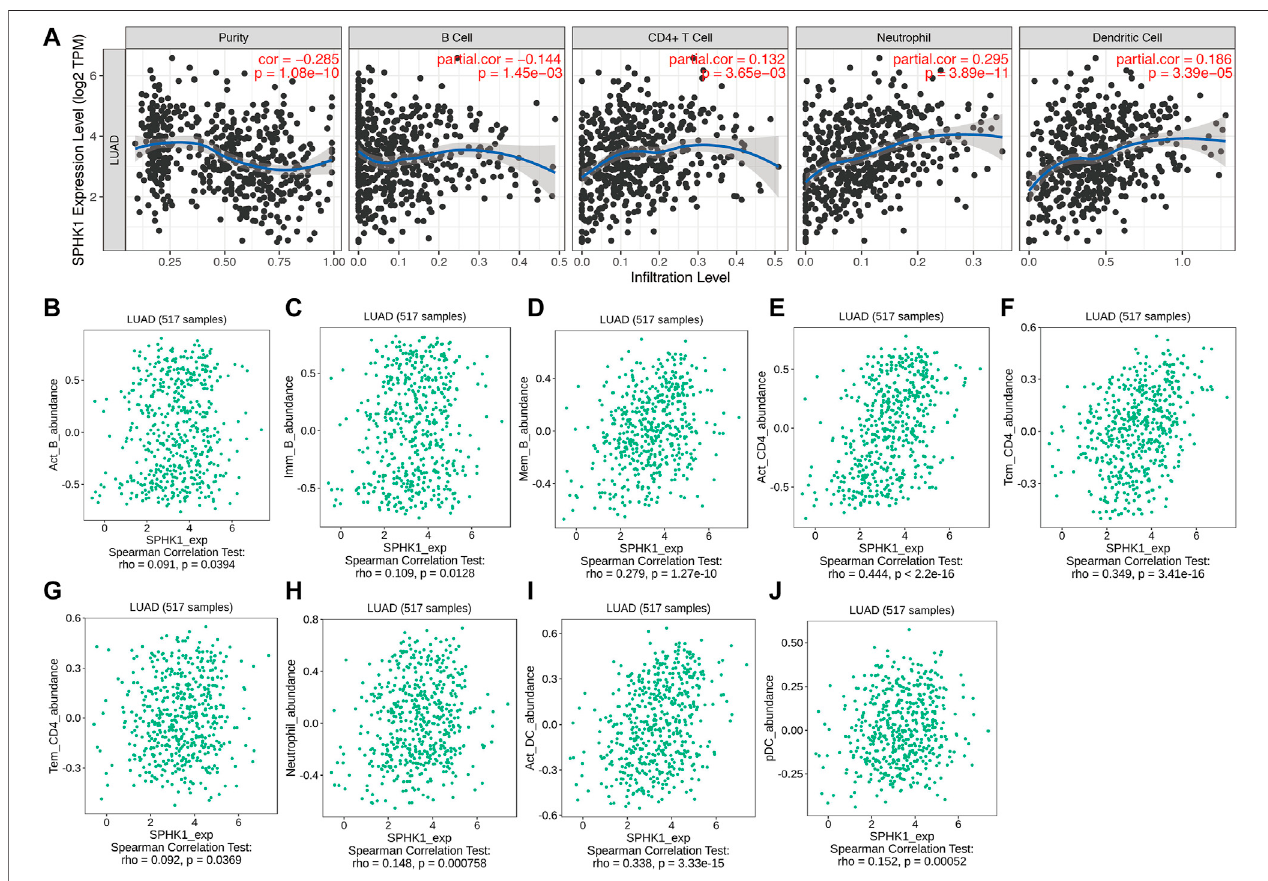
FIGURE 12 | SPHK1 expression level associated with immune cell in fi ltration levels. (A) Correlation between SPHK1 expression levels and immune cell in fi ltration levels.Correlation betweenSPHK1 expression level and BCellin fi ltration levels (B – D) , CD4 + Tcellsin fi ltration levels (E – G) , neutrophil cellsin fi ltration levels (H) , dendritic cell in fi ltration levels (I,J)